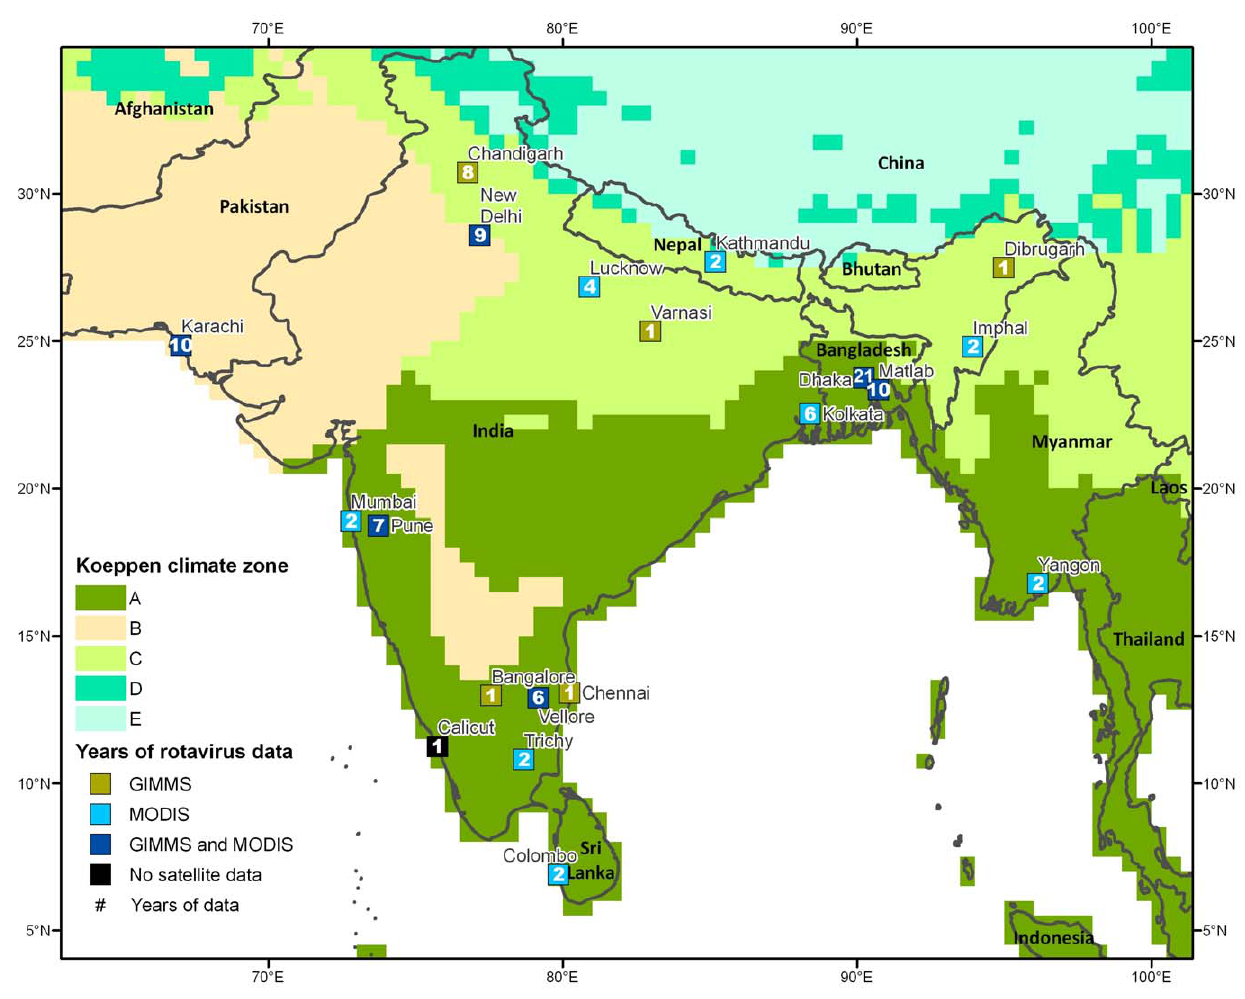
Figure 2. Map of study locations on Ko¨ppen Climate. Study locations mapped on Ko¨ppen Climate Classification system (Climate categories: A - moist tropical climates, B - arid and semiarid climates, C - humid mid-latitude areas, D - colder temperate areas) with indication of source of remote sensing data (GIMMS – Global Inventory Monitoring and Mapping Studies, MODIS – NASA’s Moderate-resolution Imaging Spectroradiometer) and number of years of data